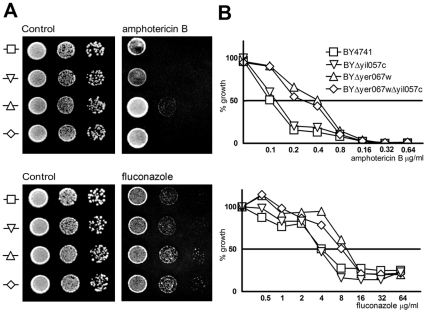
Fluconazol and amphotericin B susceptibility assay of yeast cells deleted for YER067W or YIL057C or both genes in comparison to the parental strain.(A) Qualitative assay showing BYΔYer067w drug resistance phenotype. Cells were grown up to the stationary phase and normalized to 107 cells/mL. Serial dilutions of the suspension were spotted onto YPD (control) or YPD containing 16.0 µg/mL of fluconazol and 1.0 µg/mL of amphotericin B. Plates were incubated for 48 hours at 28°C, and then photographed. (B) For a quantitative drug resistance analysis, yeast cells were grown in increasing drug concentration for 16 hours, at which point the OD600nm was determined. Complete (100%) growth was defined by the OD reached by the drug-free control for each strain. Standard errors are smaller than the graph symbols.